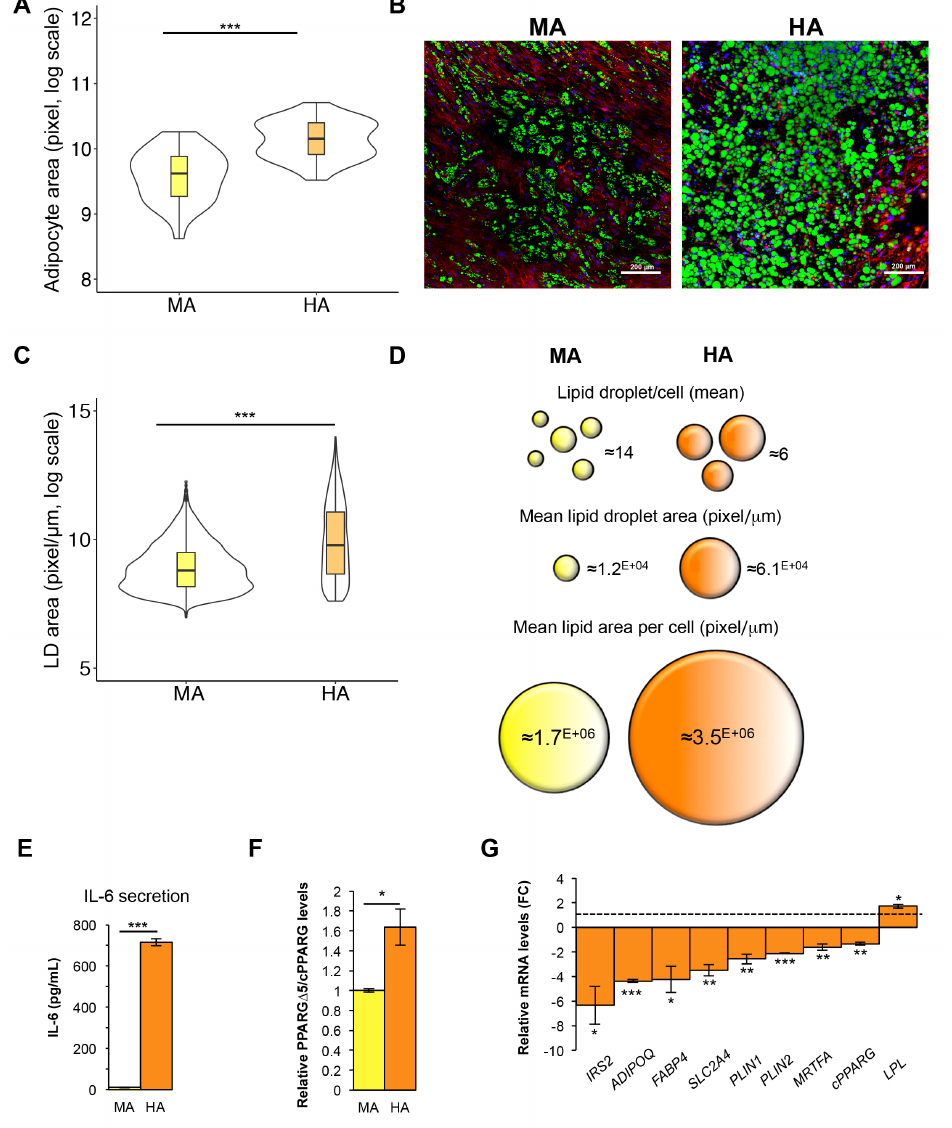
Figure 6. Di ff erences between mature and hypertrophic-like adipocytes occur in cell size, lipid droplets, IL-6 secretion, and gene expression. ( A ) Violin plot showing cell area of mature (MAs) and hypertrophic-like (HAs) adipocytes ( n = 60). *** p val ≤ 0.001. ( B ) Representative confocal microscopy images of hMSCs di ff erentiated in MAs and HAs stained with DAPI (nuclei, blue), Bodipy 495 / 503 (lipid droplets, green) and WGA 632 / 647 (cell membranes, red; scale bars, 200 µ m). ( C ) Violin plot showing lipid area / cell measured by 3D analysis on 2973 LDs (from 214 MAs) and on 1168 LDs (from 206 HAs). *** p val ≤ 0.001. ( D ) Schematic representation of 3D analysis results from LDs in MAs and HAs (i.e., mean of number of LD / cell, LD area, and total LD area / cell), as described in B. ( E ) Bar graph reporting IL-6 concentration (pg / mL) determined by ELISA on culture supernatant of MAs and HAs. Data are reported as mean ± SEM from three independent experiments. *** p val ≤ 0.001. ( F ) Relative PPARG ∆ 5 / cPPARG mRNA levels (qPCR) in MAs and HAs. MAs were used as reference sample and PPIA as reference gene. Data are reported as mean ± SEM from three independent experiments. *** p val ≤ 0.001. ( G ) Relative mRNA quantifications (signed fold-changes) in HAs vs. MAs (dotted line). PPIA was used as reference gene. Data are reported as mean ± SEM from three independent experiments. * p val ≤ 0.05, ** p val ≤ 0.01 and *** p val ≤